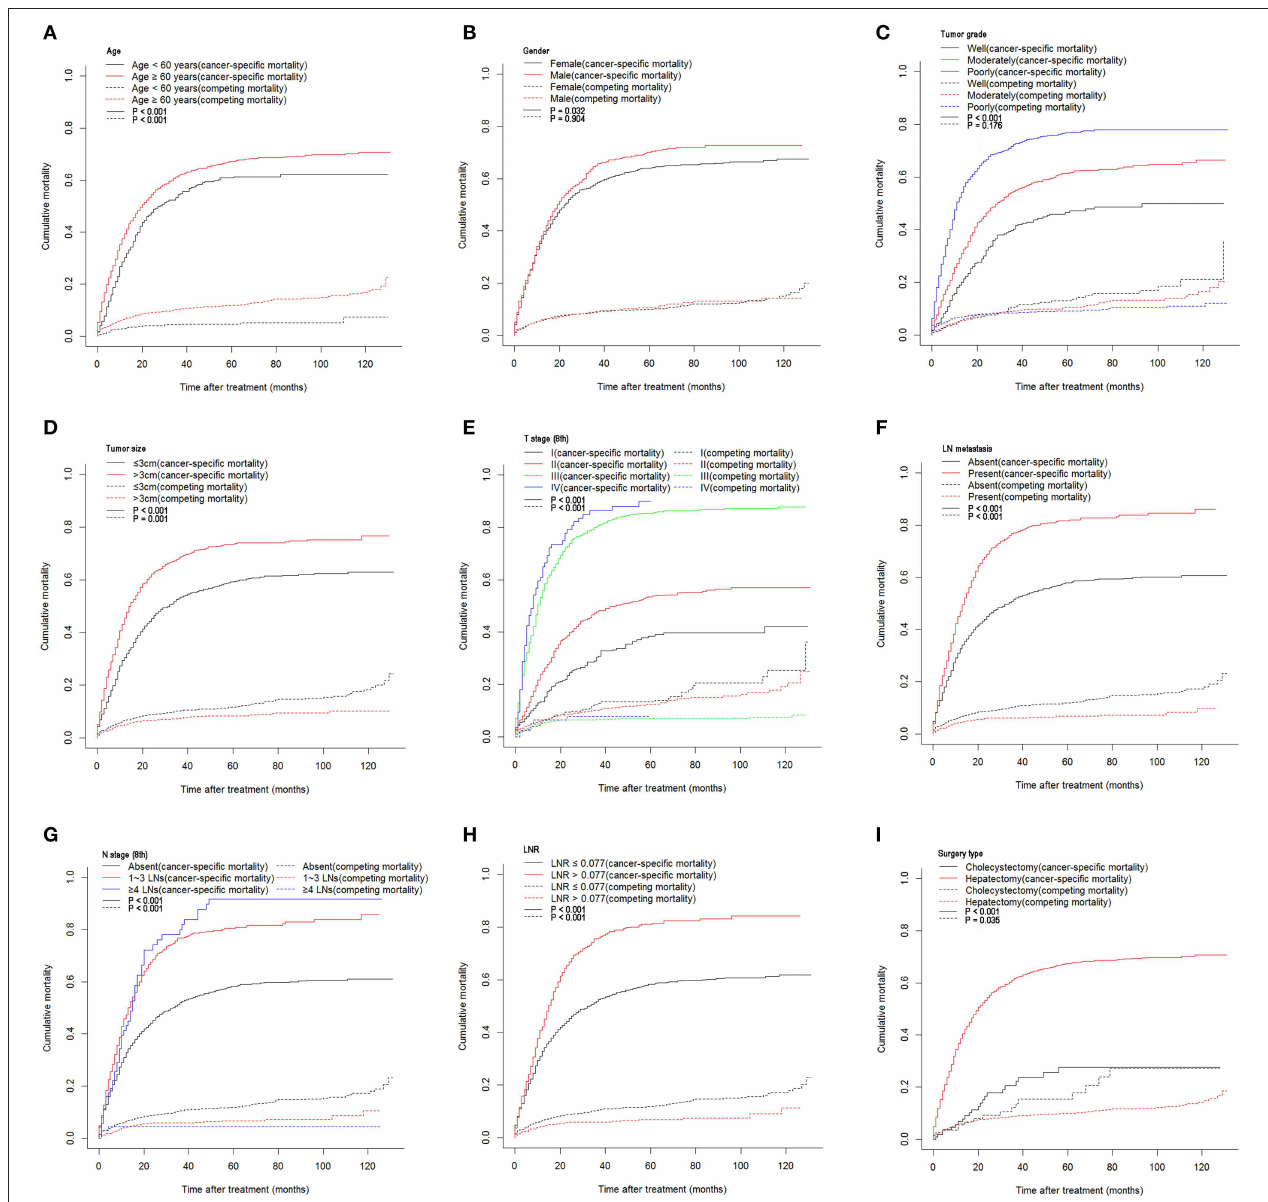
FIGURE 1 | Cumulative cancer-specific and competing mortality stratified by patient characteristics: (A) age; (B) gender; (C) tumor grade; (D) tumor size; (E) T stage (8th); (F) LN metastasis; (G) N stage (8th); (H) LNR; (I) surgery type. LN, lymph node; LNR, lymph node ratio.